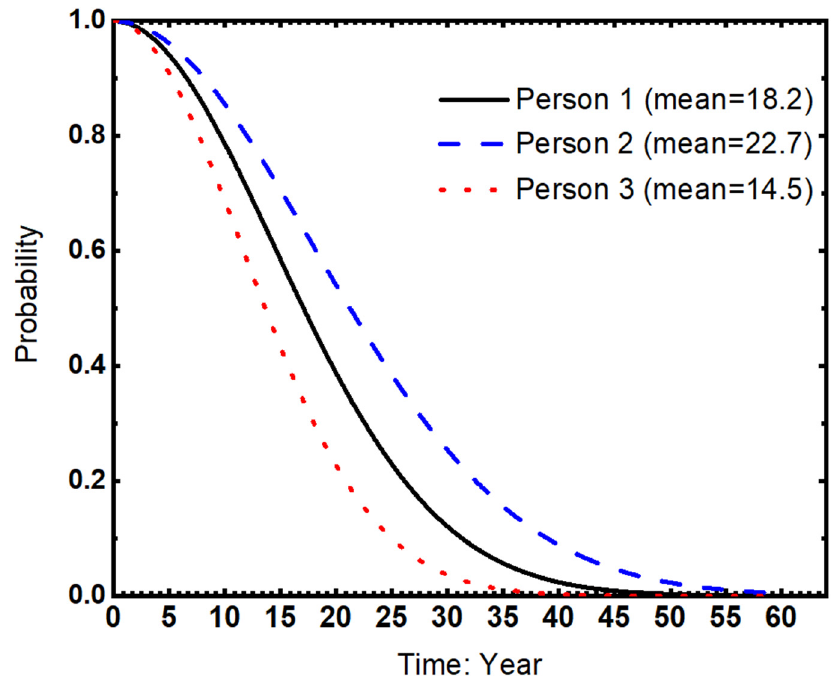
Figure 1. Individual-level life expectancy for simulated individuals. Note. Person 1: 60, male, primary school or below, agriculture work, married/living together, HRQoL = 1; Person 2: 60, male, high school or above, agriculture work, married/living together, HRQoL = 1; Person 3: 60, male, primary school or below, unemployed, married/living together, HRQoL = 1.